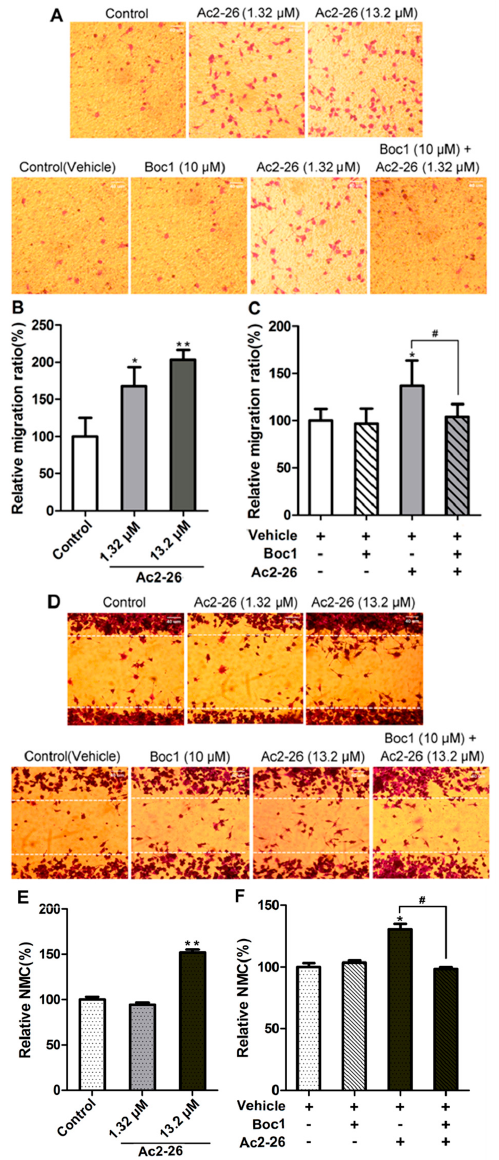
Figure 7. Annexin-1 (ANXA1) mediates BV-2 migration via formyl peptide receptors (FPRs). ( A ) Photographs illustrating the effect of Ac2-26 (1.32 μ M) and Boc1 (10 μ M) on BV-2 cell migration in trans-well migration assays. Photographs were taken from the lower sides of the chamber’s membrane. Violet particles represent cresyl violet-stained BV-2 cells; ( B ) the relative migration ratio as a percentage relative to the control group; ( C ) the relative migration ratio as a percentage relative to the control + dimethyl sulfoxide (DMSO) group; ( D ) photographs illustrating the effect of Ac2-26 (1.32 μ M) and Boc1 (10 μ M) on BV-2 cell migration in scratch wound assays. Cells between the two white dotted lines were considered migrating cells; ( E ) the relative number of migrating cells (NMC) as a percentage relative to the control group; ( F ) the relative number of migrating cells (NMC) as a percentage relative to the control + DMSO group. BV-2 cells were cultivated under normal conditions for these experiments. All data are expressed as the mean ± standard error of the mean (SEM) ( n = 5–15). * p < 0.05, ** p < 0.01 (compared to the control group), # p < 0.05.. Scale bar: 40 μ m.